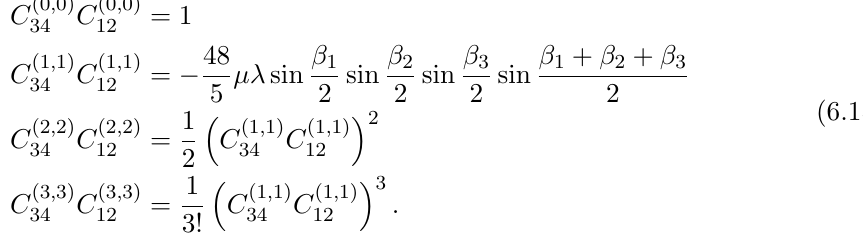
0 ) 0 ) C ( p;p are shown for di(cid:11)erent choices of (cid:12) i 34 12